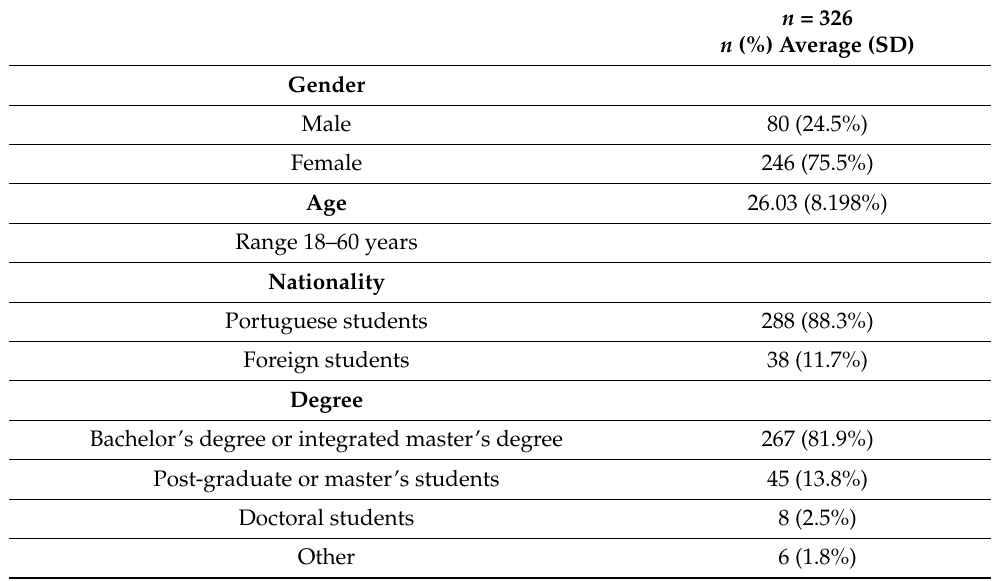
Table 1. Sociodemographic characteristics of